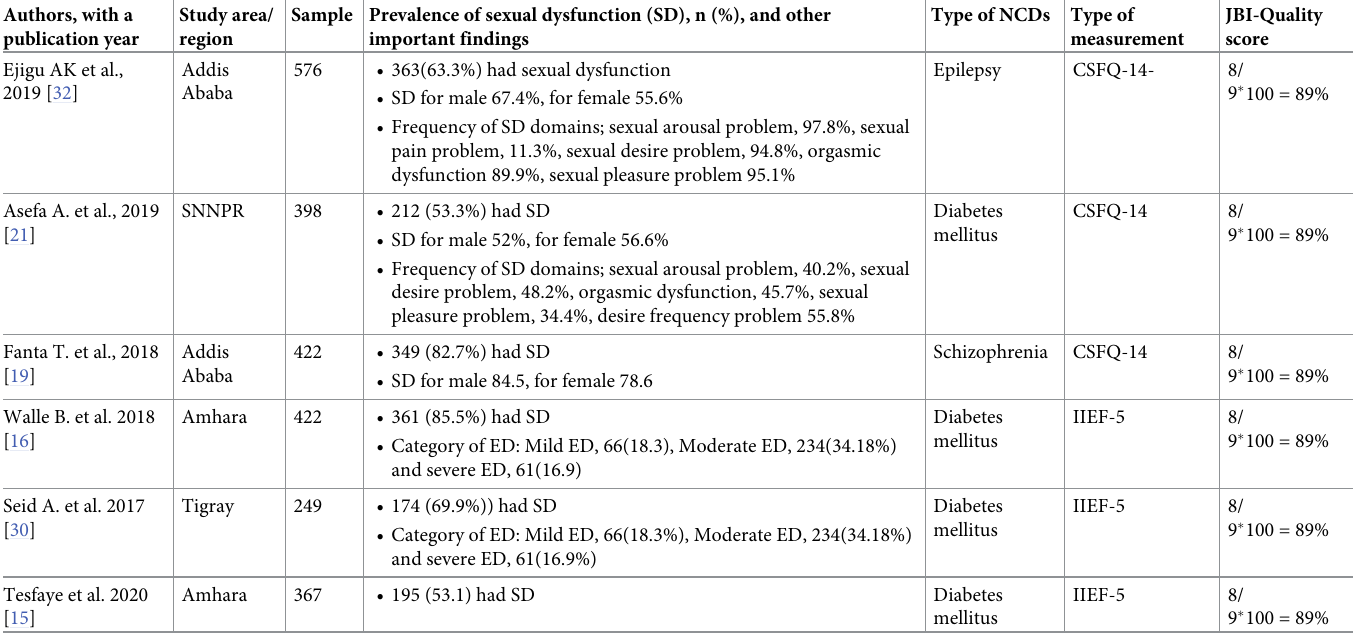
Table 1. Description of the included